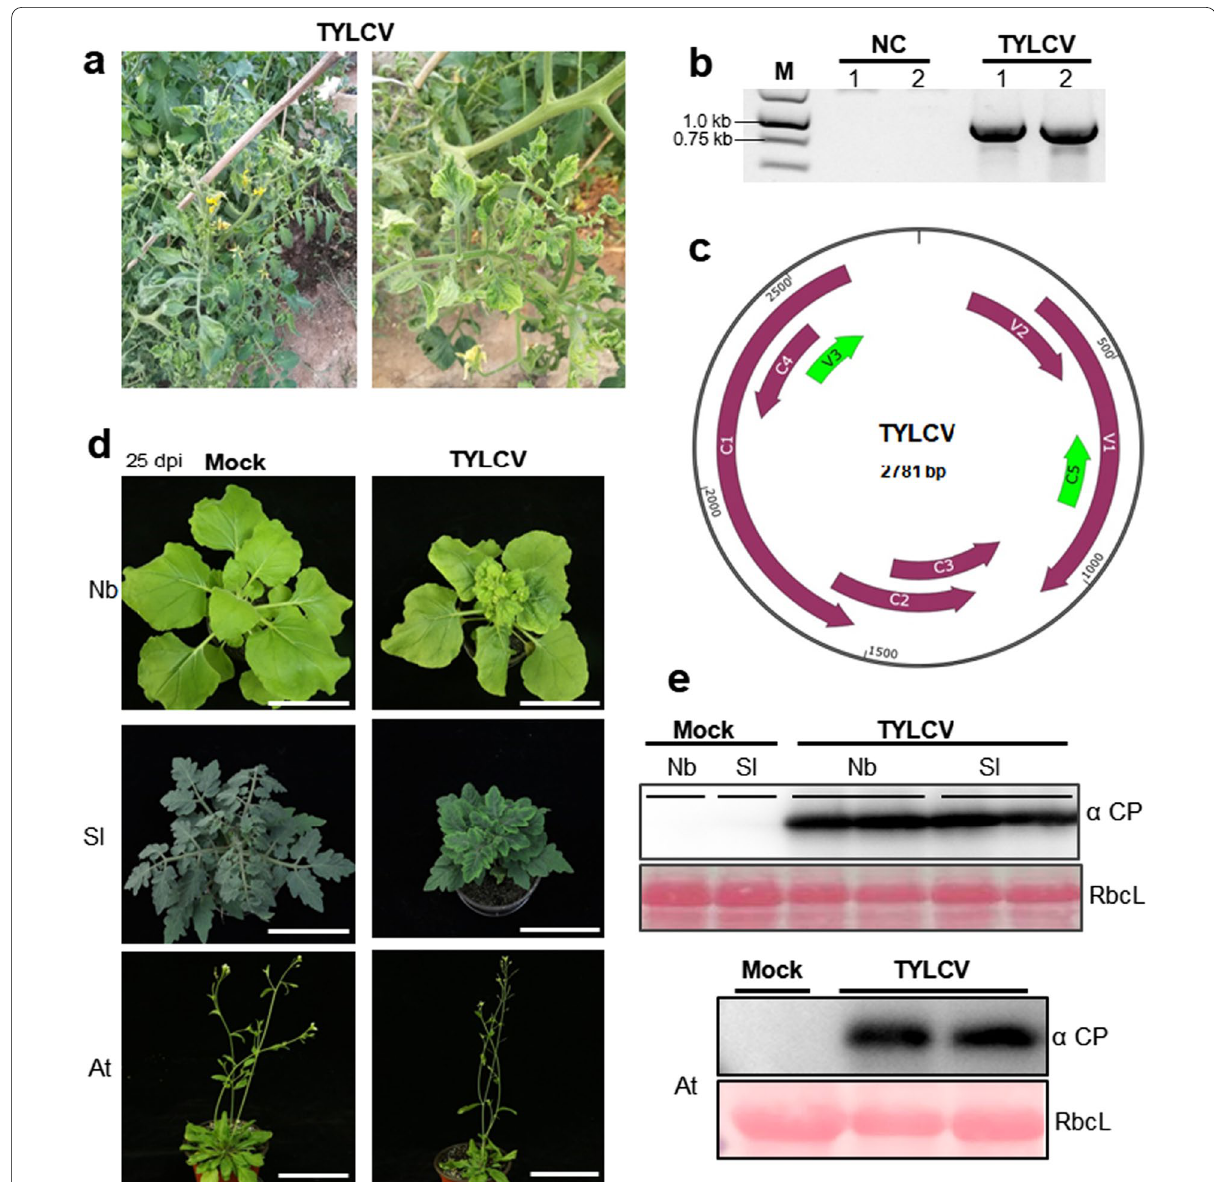
Fig. 1 Disease symptoms caused by tomato yellow leaf curl virus (TYLCV) and genome organization of TYLCV. a Disease symptoms induced by TYLCV in Solanum lycopersicum plants in the field. b Specific DNA bands detected in infected tomato plants by PCR using TYLCV-specific primers. Lanes 1 and 2 indicate DNA extracted from two independent TYLCV-infected S. lycopersicum plants. M: DNA ladder marker, NC: negative control using DNA extracted from uninfected tomato plants. c Schematic representation of TYLCV genomic organization. Open reading frames encoded on the virion-sense (V) strand and complementary-sense (c) strand are denoted (V1, V2, C1, C2, C3, and C4); the new ORFs V3 and C5 have been identified recently (Gong et al. 2021). d Disease symptoms induced in Nicotiana benthamiana (Nb), S. lycopersicum (Sl), and Arabidopsis thaliana (At) plants agroinoculated with mock (empty vector) or the infectious clones of TYLCV. Plants were photographed at 25 days post inoculation (dpi). Bars 9 cm. e Western blot analysis of total proteins from ( d ) with anti-TYLCV-coat protein (CP) antibodies. Ponceau S staining of the large Rubisco = subunit (RbcL) served as the loading control. Note : The TYLCV Beijing isolate (GenBank Accession No. MN432609) was used in this